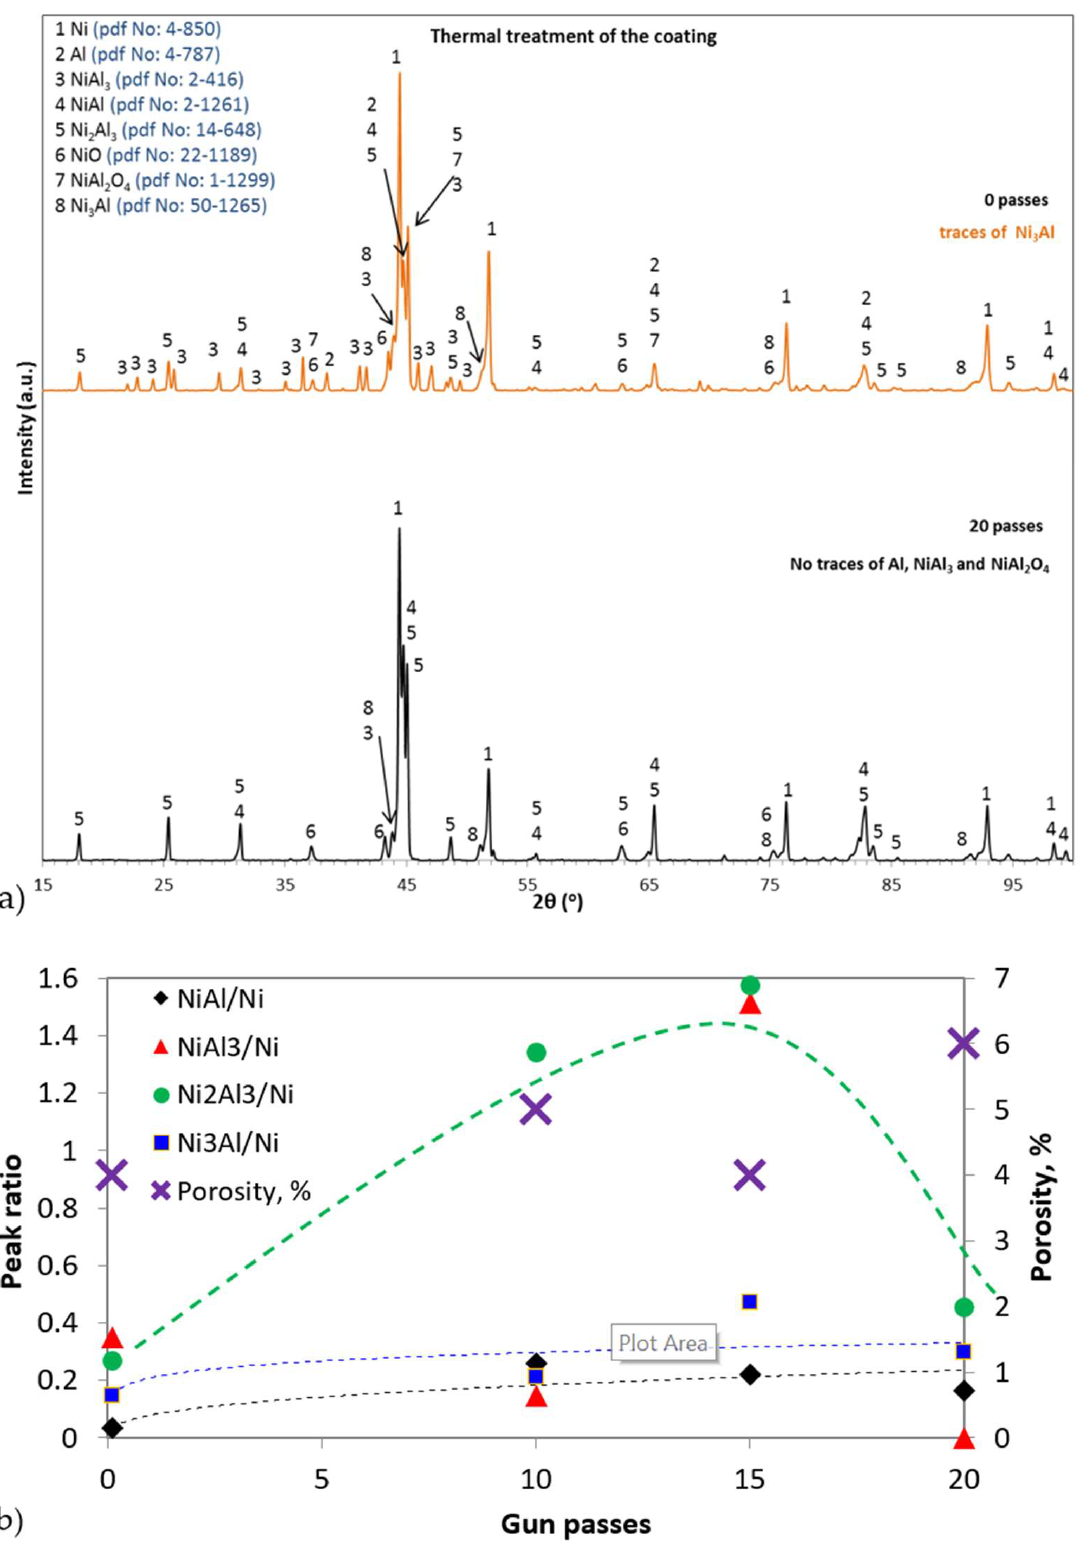
Figure 8. ( a ) XRD pattern of the surfaces changing the postdeposition heat treatment (using data of [28]) and ( b ) coating porosity and semiquantitative analysis of the intermetallic phases in the coatings as functions of the postdeposition heat treatment of the coating: 0 passes: COATR 1; 10 passes: COATR 2; 15 passes: COATR 3; 20 passes: COATR 4.